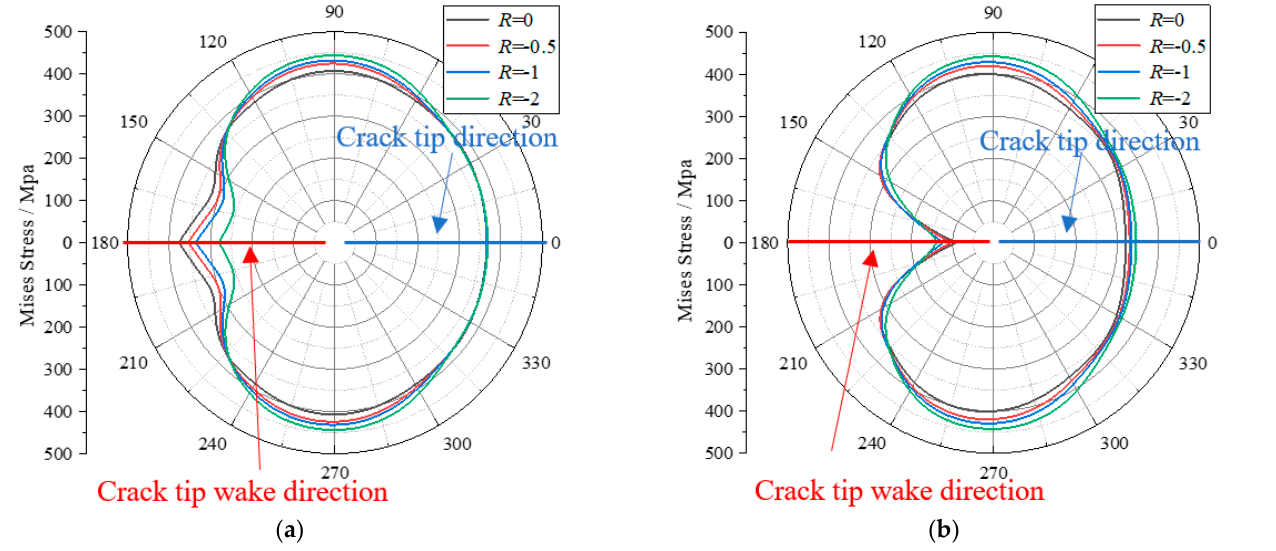
Figure 11. Effect of loading ratio R on Mises stress distribution: ( a ) Peak loading point, ( b ) Valley loading point.